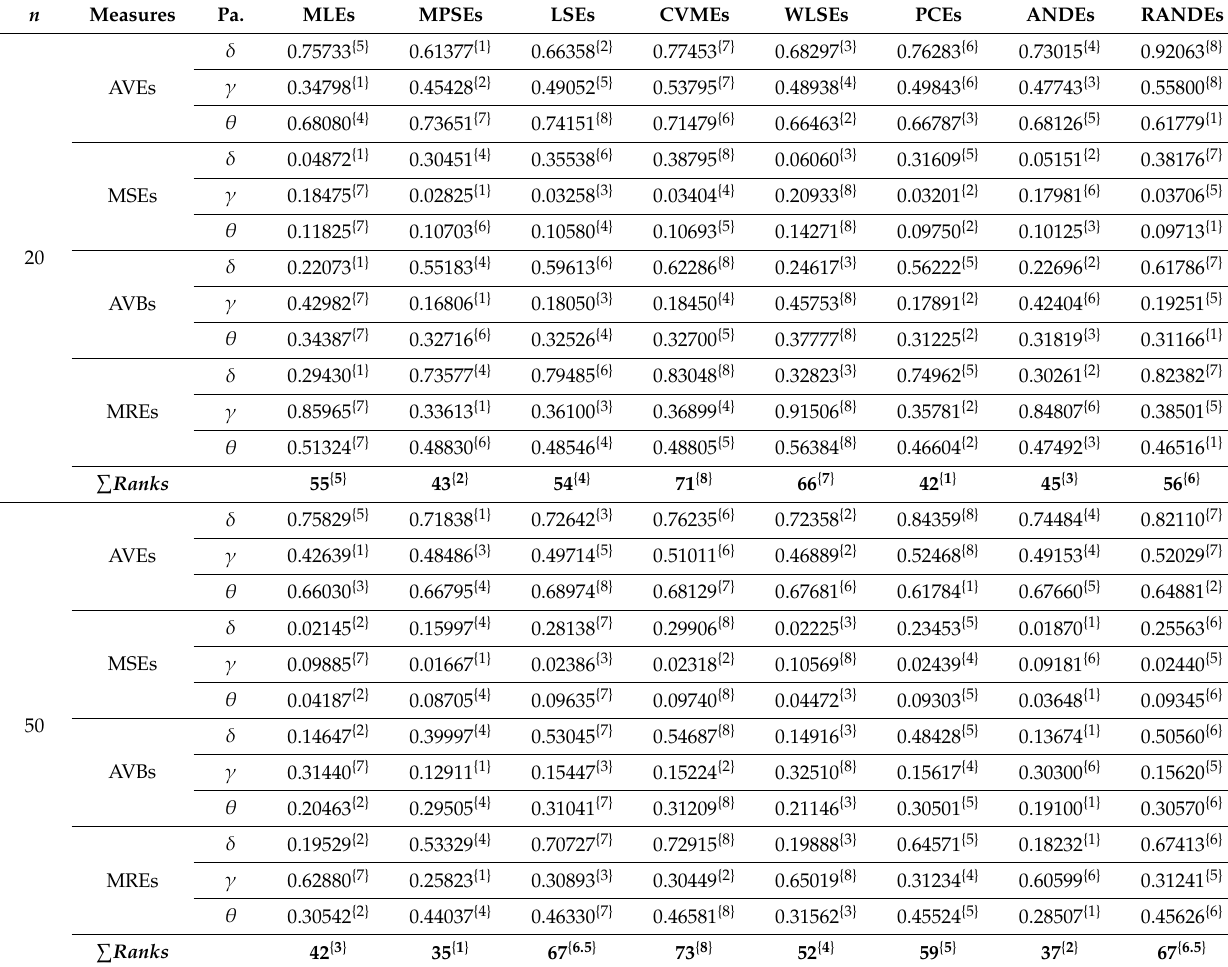
Table A1. Simulation results of several estimation methods for δ = 0.75, γ = 0.50 and θ =